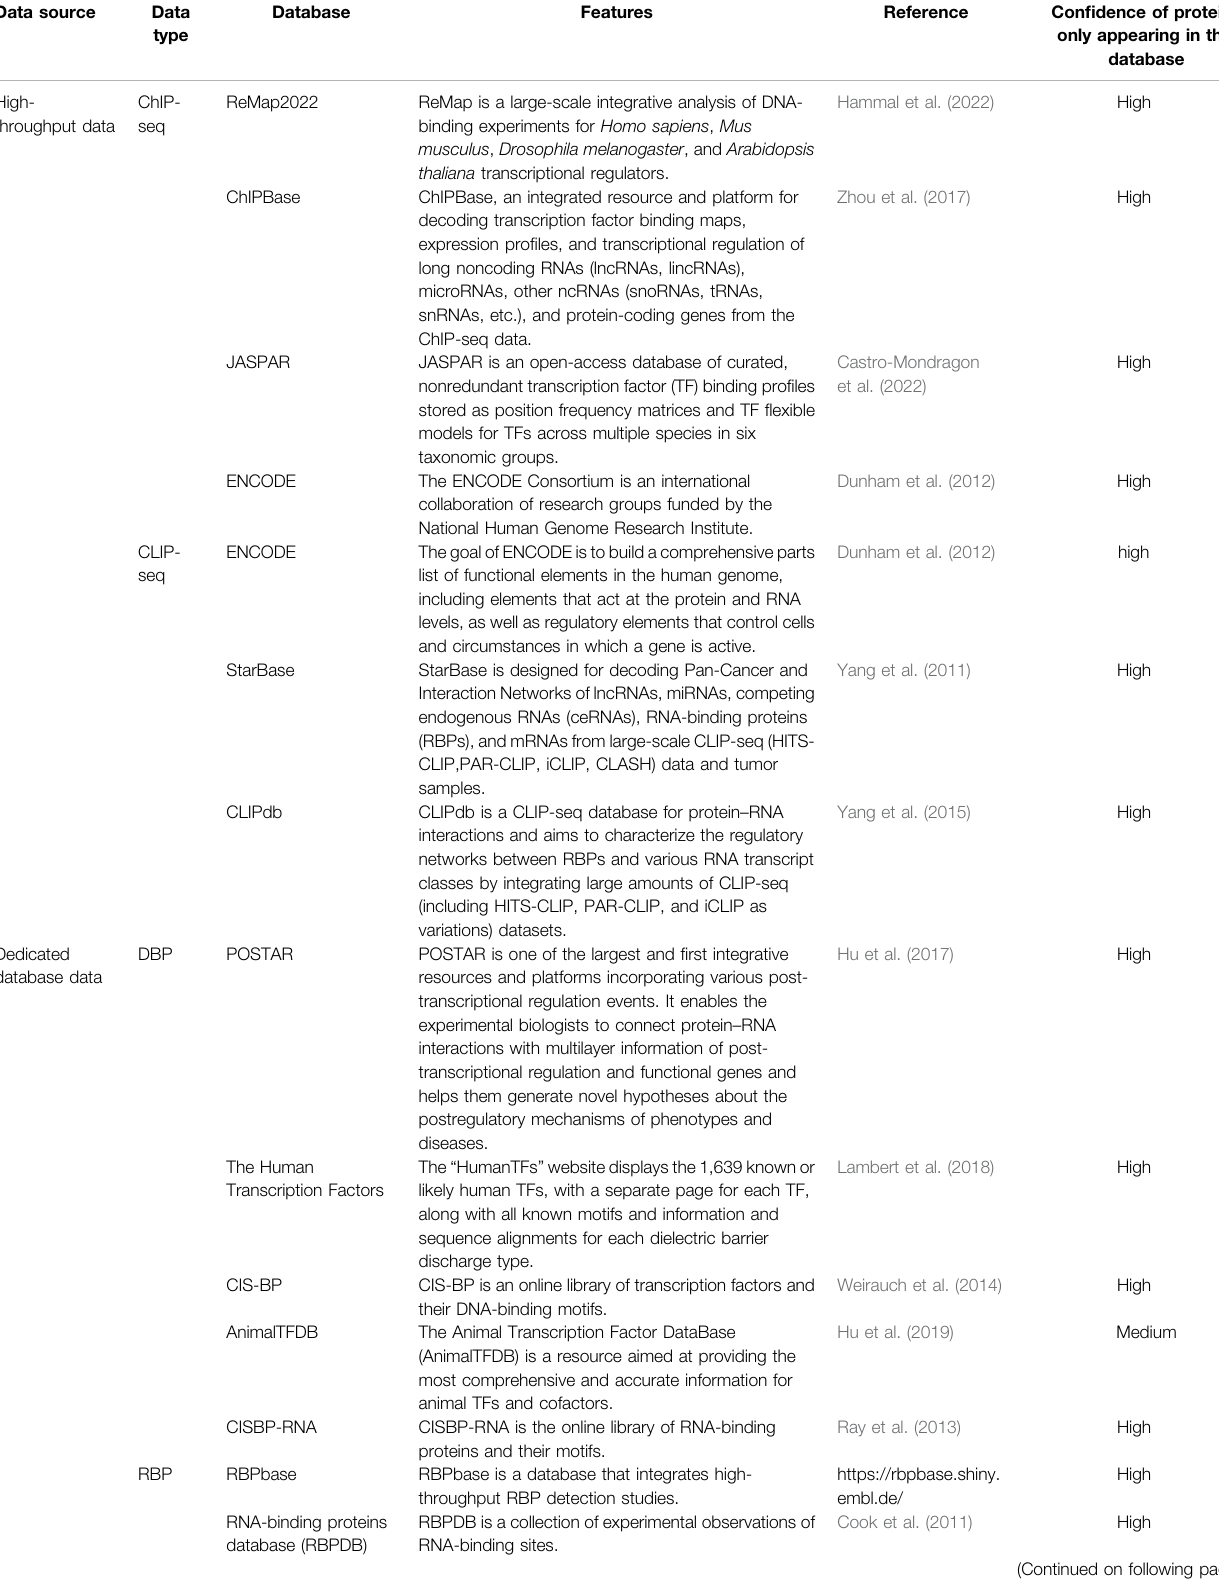
TABLE 1 | Data sources for DBPs and